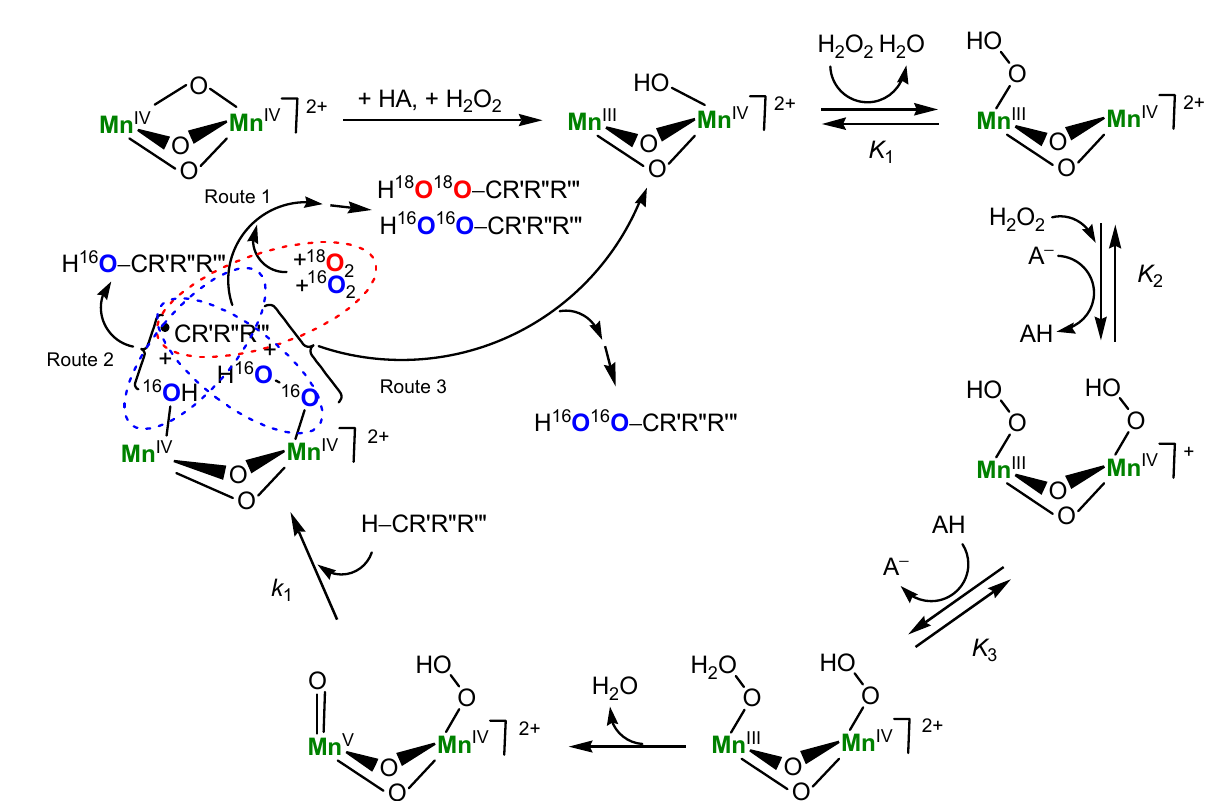
Figure 20. A catalytic cycle proposed for the alkane hydroperoxidation in the presence of 18 O 2 (in an atmosphere 16 O 2 + 18 O 2 ). AH is a carboxylic acid where A is its anion. Adapted from [120], Copyright (2017) with permission of Elsevier.